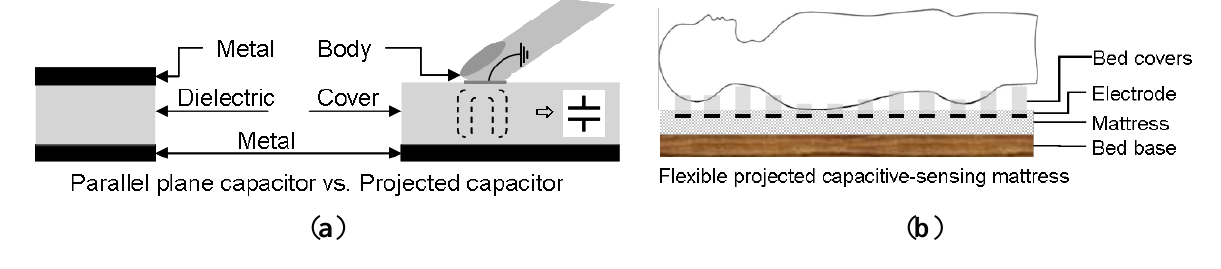
Figure 1. ( a ) Structure comparison of parallel plane capacitor and projected capacitor; ( b ) Flexible projected capacitive-sensing